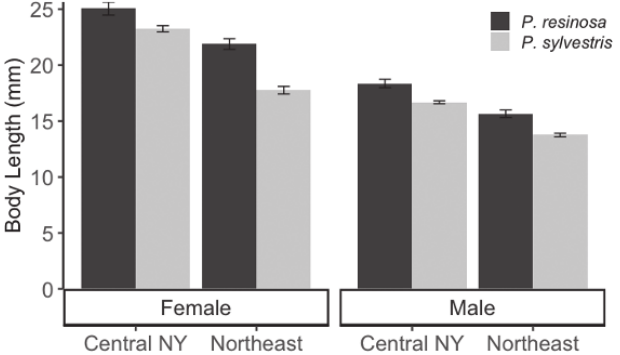
Figure 1. Body size variation in Sirex noctilio . Females were larger than males and insects emerging from Pinus resinosa were larger than those emerging from P. sylvestris (Central NY and Northeast data sets plot- ted separately). Bars show mean ± SE.